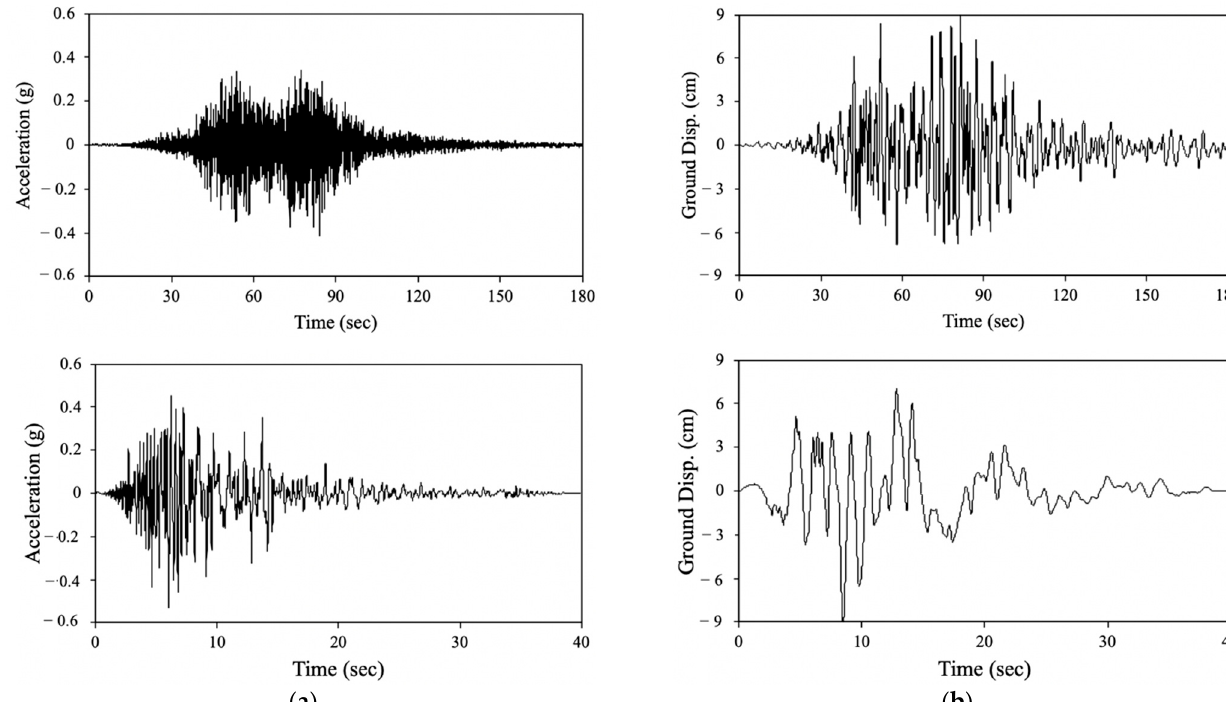
Figure 11. Time histories for the Curico X ( top ) and Capitola X record ( bottom ): ( a ) Acceleration; ( b ) Displacement.